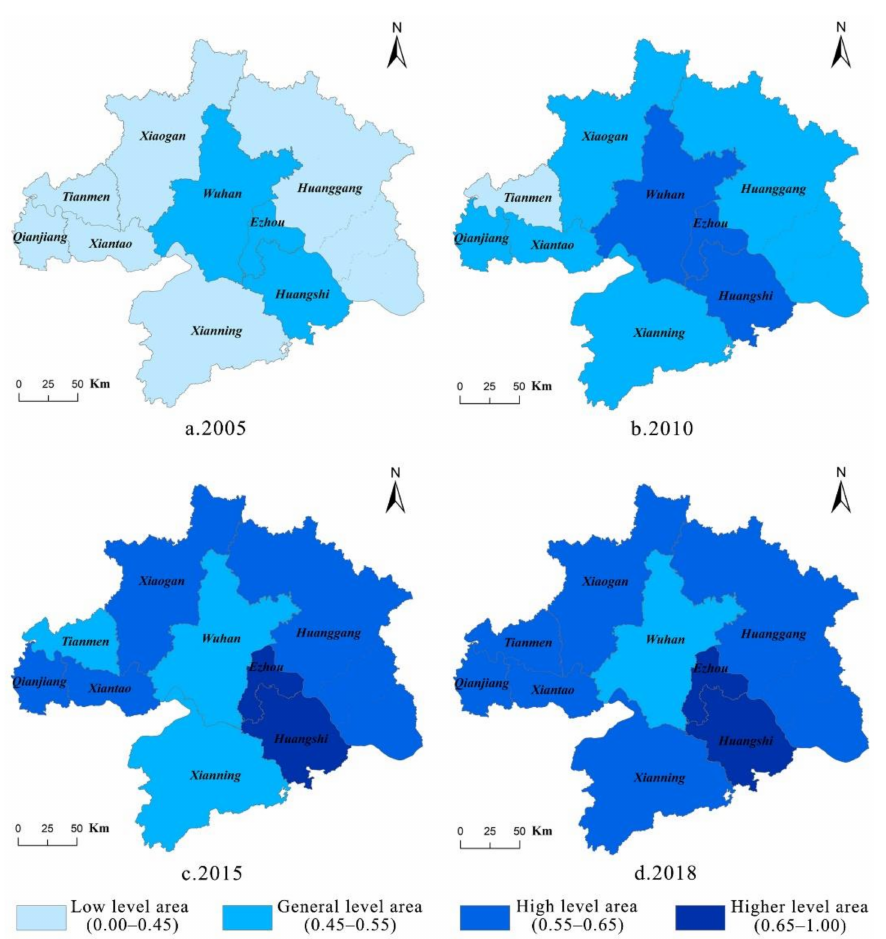
Figure 6. Spatial distribution of the coupling coordination degree.